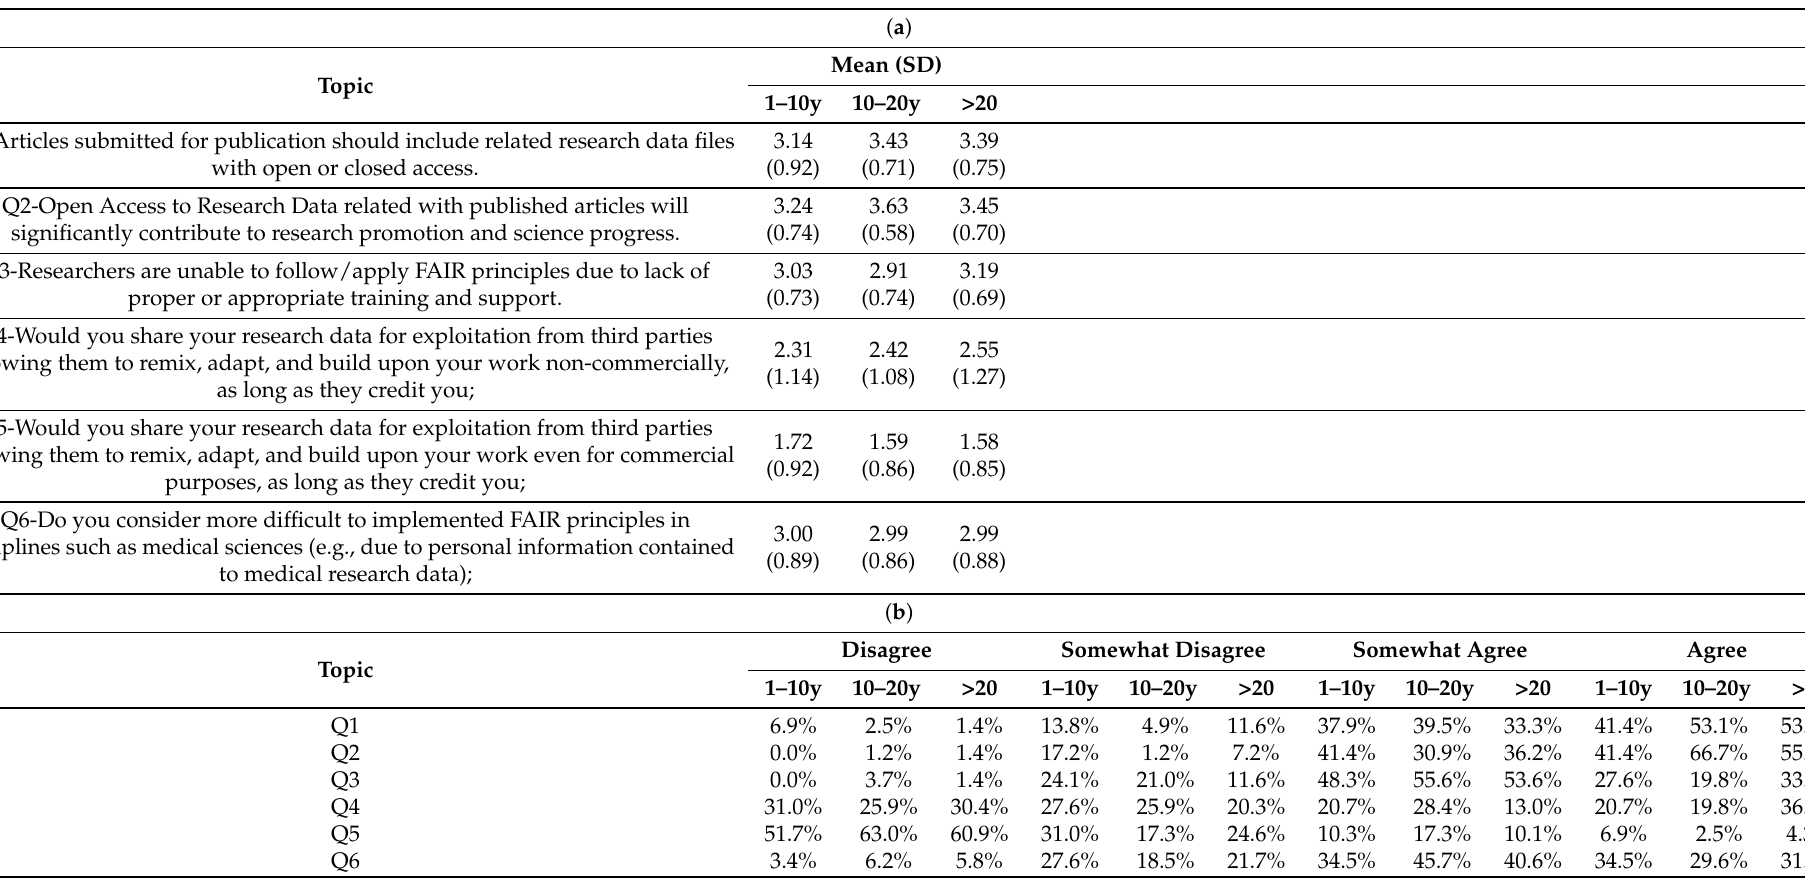
Table 5. ( a ) Define the level of agreement with the following topics regarding Open Research Data-Percentages per topic-Mean and Standard Deviation per topic (Part 2, Q1 to Q6, years of experience: 1–10y, 10–20y, >20y); ( b ) Define the level of agreement with the following topics regarding Open Research Data-Percentages per topic-Percentages per topic (Part 2, Q1 to Q6, years of experience: 1–10y, 10–20y,